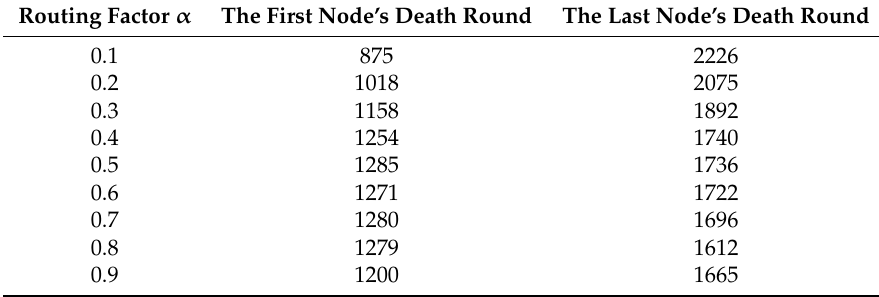
Table 2. A comparison of the first and last node’s death round in homogeneous networks with different routing factor α .